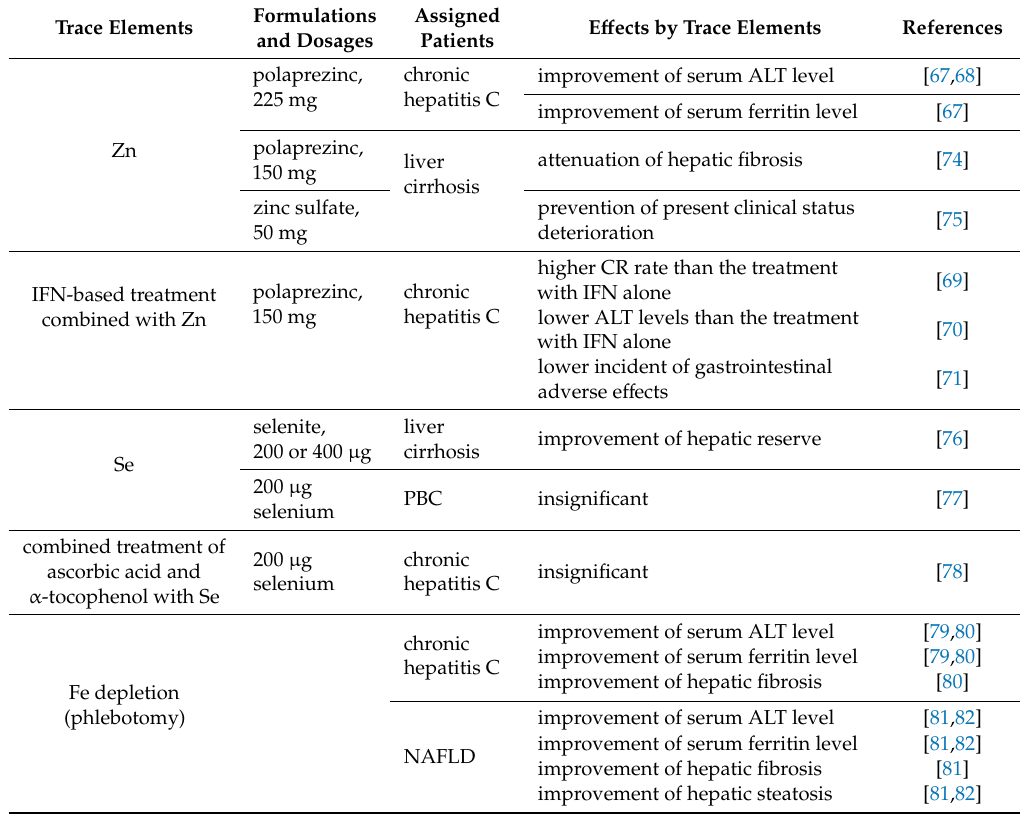
Table 3. Summary of the clinical trials on administration or depletion of the trace elements in patients with